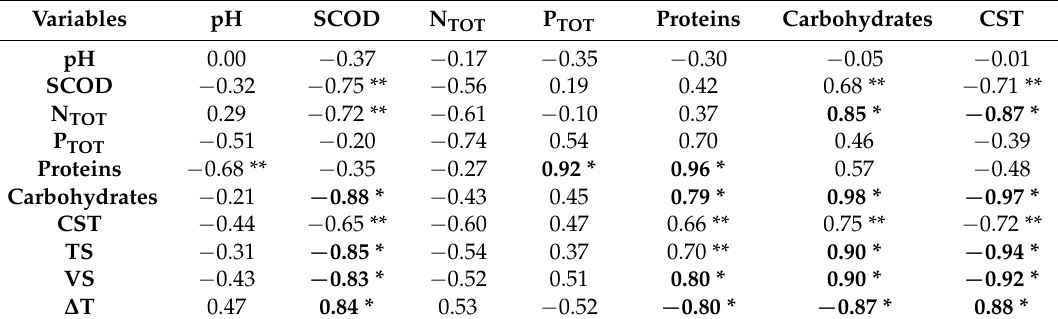
Table A2. Pearson’s correlation coefficients for the direct effects of WAS ultrasonic disintegration WK-2010).